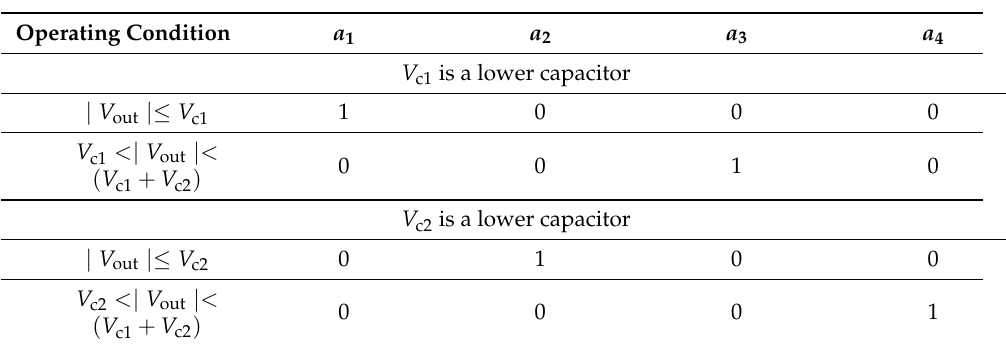
Table 3. PWM Operating